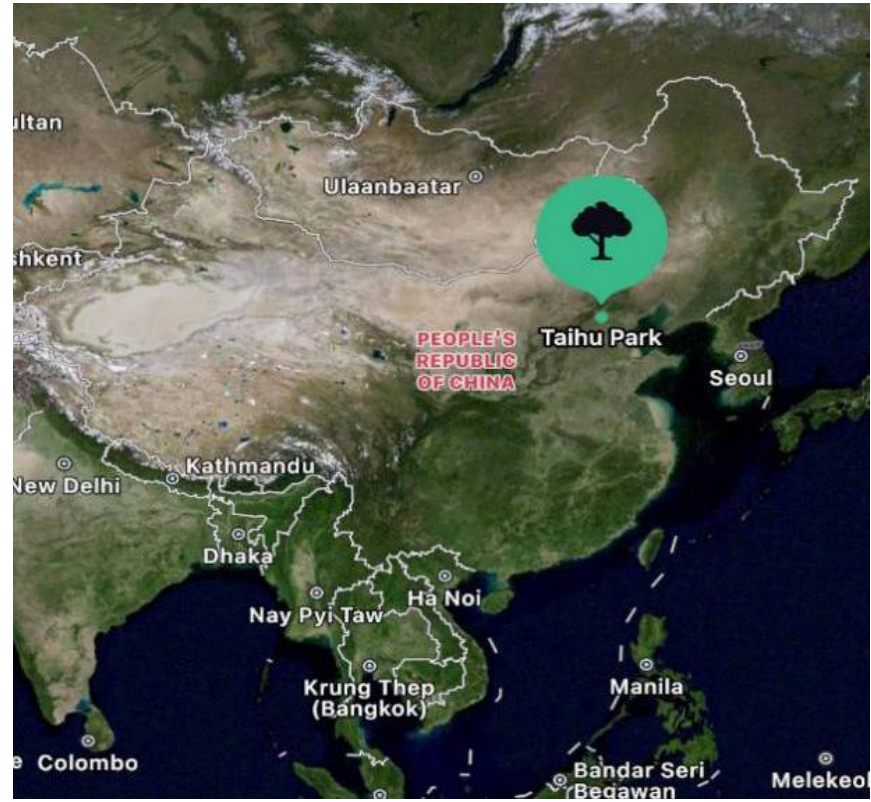
Figure 2. Location of Taihu Park in China.